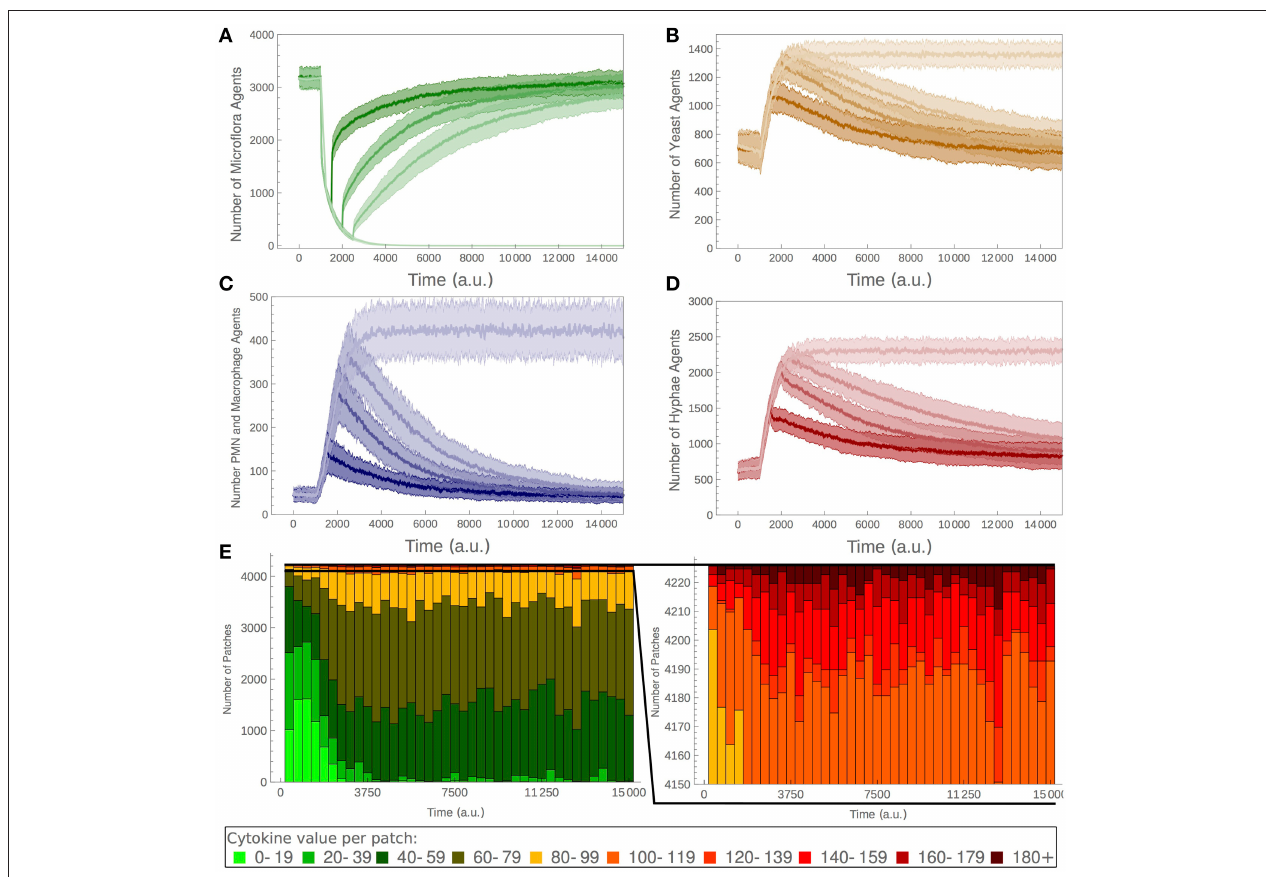
FIGURE 3 | Simulation of the model upon MD treatments. Duration of the MD treatment (see Table 1 for more details) affects the ability of the system to recover. Model simulations with MD applied at t = 1000 ts and removed at either t = 1500 ts , 2000 ts , or 2500 ts . (A) Number of microflora agents, (B) yeast agents, (C) PMN and macrophage agents, and (D) hyphae agents. (E) Cytokine levels counted for all MCs upon continuous application of the MD drug.